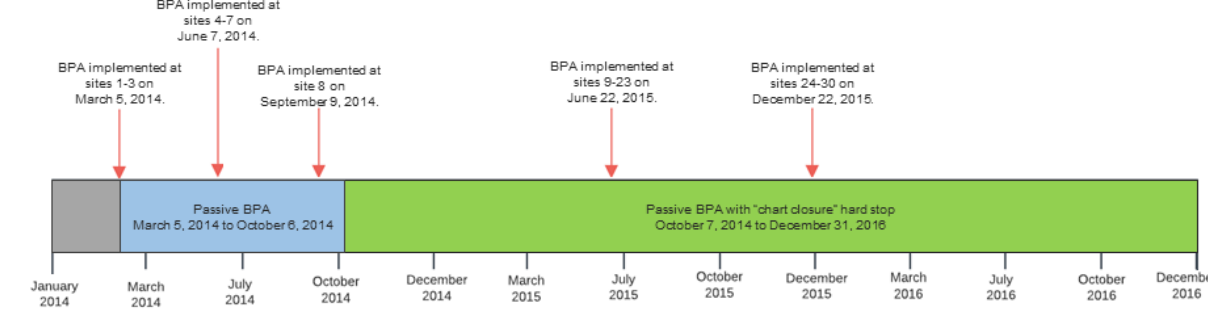
Figure 3. Best Practice Advisory implementation at 30 University of California at Los Angeles Health primary care sites over a 15-month rollout period. The period of interest for this study is from January 2014 to December 2016. BPA: Best Practice Advisory.